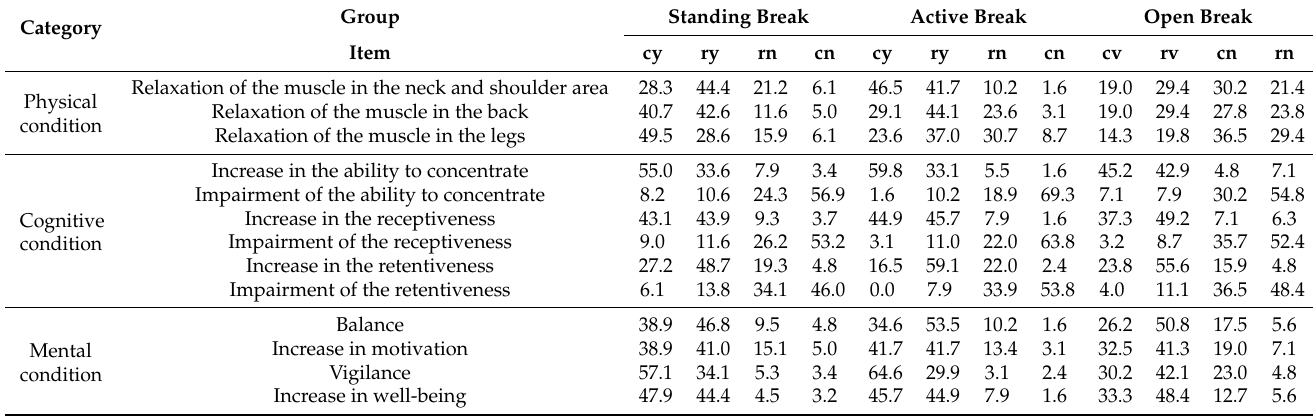
Table 4. Students’ subjective perception during the standing break, active break, or open break during the lectures at midsemester in % (N = 631).